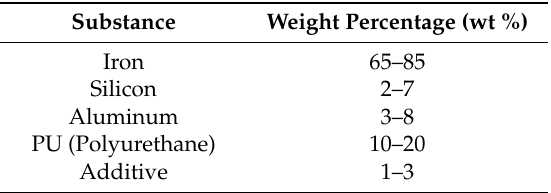
Table 1. Composition percentage of ferrite film [31].